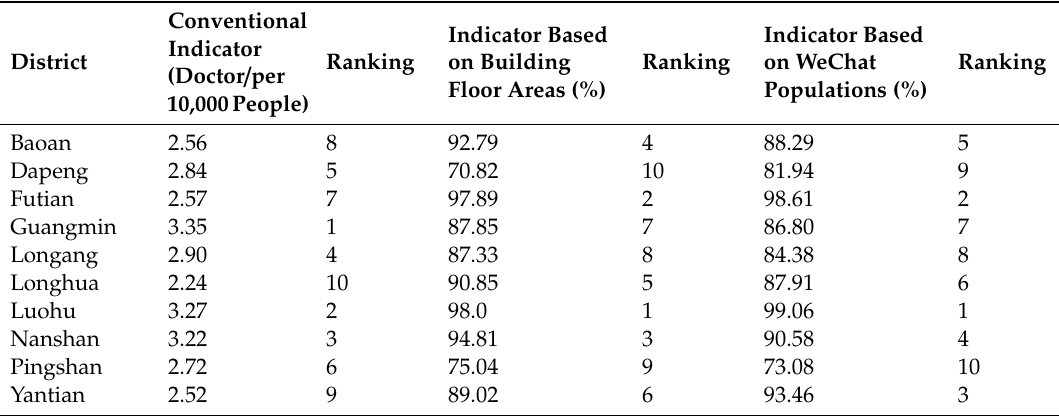
Table 4. Rankings of districts by the indicator of health